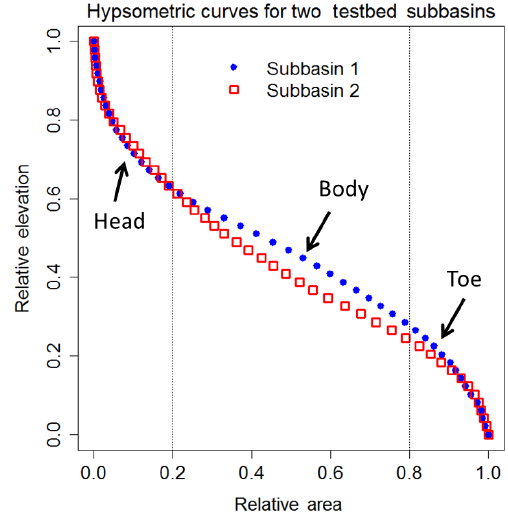
Figure 3. Hypsometric curves of two subbasins with extreme con- trast of elevation variability discretized into three parts following Willgoose and Hancock (1998) and Sinha-Roy (2002): the head, body and toe, as used in the local